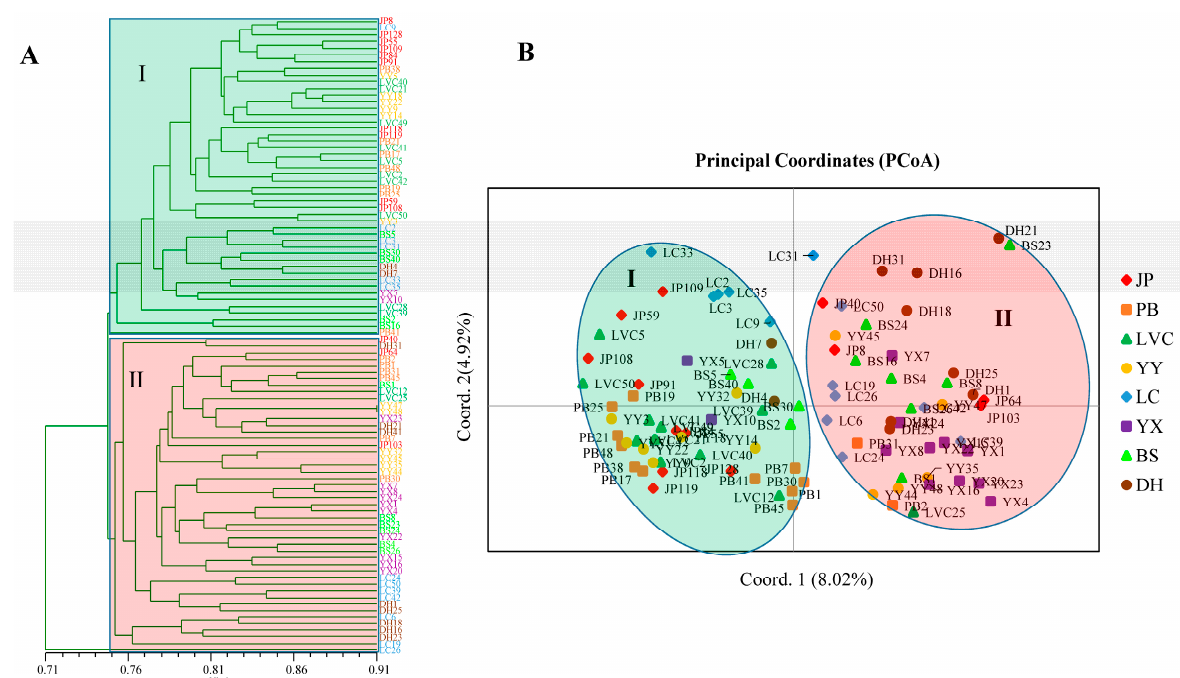
Figure 6. UPGMA cluster ( A ) and principal coordinates analysis (PCoA) ( B ) of the 96 A. tsao-ko ac- cessions based on PAAP and CDDP